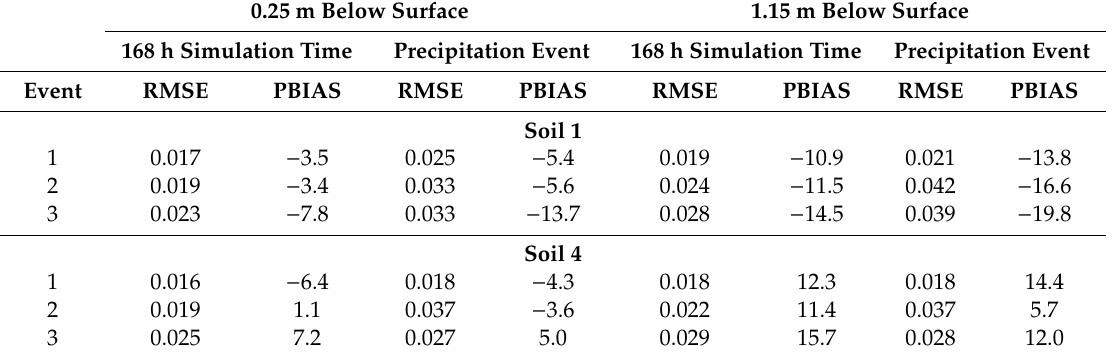
Table 6. Model fitness of water content for the total simulation time of 168 h in the course of a precipitation event and for the period most influenced by the precipitation event for the upper (0.25 m below surface) and lower (1.15 m below surface) observation points for soil 1 and 4, RMSE (V WC) and PBIAS (%). 0.25 m Below